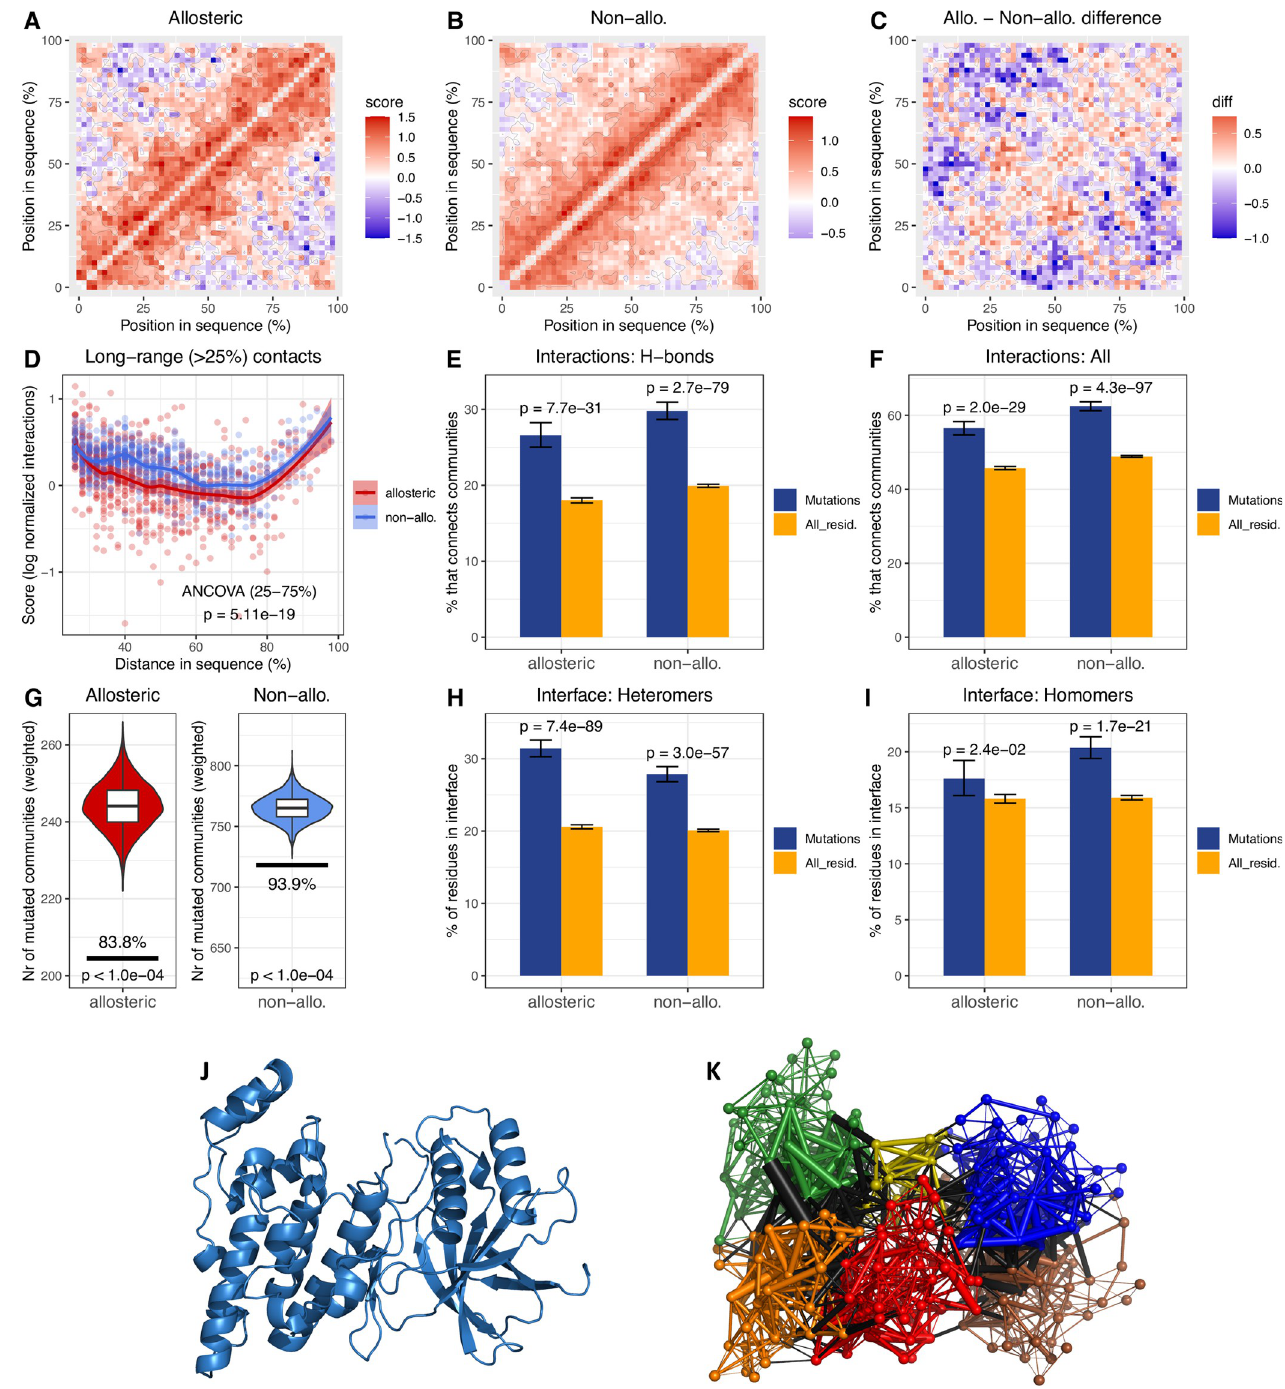
Fig 6. Structural and dynamical characteristics of pathogenic mutations in allosteric and non-allosteric proteins. A-B) Residue interaction matrix of Pfam domains of allosteric (A) and non-allosteric (B) proteins. C-D) The difference between the two matrices (panel C) shows that allosteric proteins have significantly fewer long-range interactions in their Pfam domains than non-allosteric proteins (panel D), and are likely to be more flexible. E-F) Disease associated mutations are significantly enriched in community interfaces, i.e. residues that interact with members of other communities, both in the case of allosteric and non-allosteric proteins. The enrichment is more pronounced for stronger interactions like H-bonds (panel E). G) The distribution of disease mutations across communities (horizontal bar) differs from the random expectation (violin plot) more in allosteric proteins than in non-allosteric ones, indicating that pathogenic mutations have a stronger effect in allosteric proteins. See also S9 Fig. H) Disease associated mutations are significantly enriched in the protein-protein interfaces of both allosteric and non-allosteric heteromers. I) A much less pronounced, but also significant enrichment is present in the